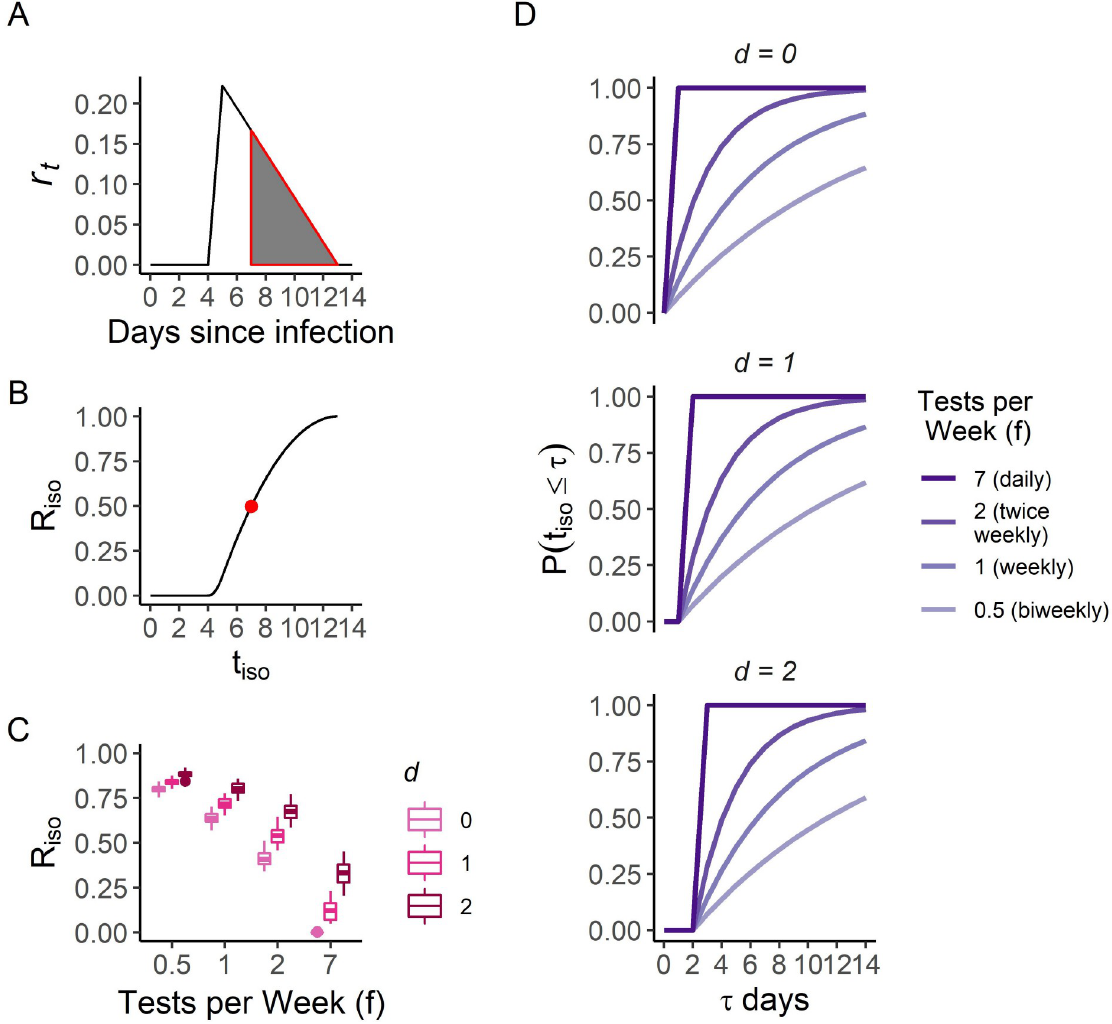
Fig 1. Analytic framework exploring effects of variable infectiousness through time, testing frequencies, and delays on SARS-CoV-2 transmission. A) Example infectiousness profile for R ¼ 1 , t through time and shaded area demonstrating infectiousness slice removed if t iso = 7 , leading to R same parameters as in A and point indicating scenario depicted in A. C) Boxplots showing distributions of R frequency, f , and delay in obtaining test results, d , incorporating uncertainty in t sets for each, with baseline R ¼ 1 . Boxplots indicate median, interquartile range, and full range of values of R occurs as a function of testing frequency, f , delay in obtaining test results, d , and days from exposure to isolation τ , i.e. t that delays in obtaining test results substantially reduce the probability of prompt isolation, particularly among most frequent testing